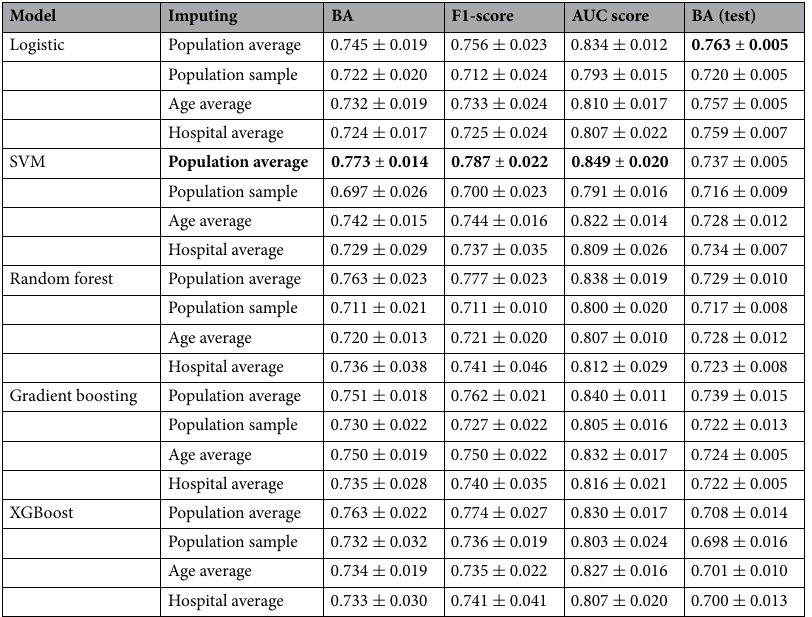
Table 1. Classical machine learning model performance on training data, on average the SVM model family performs the best during the cross-validation phase. Checking the held-out test performance of each model class, we can see in contrast to the cross-validation phase, in generalization (performance gap on unseen data) the logistic model is actually the best. Performance measure for the best model is noted in each column by using bold face